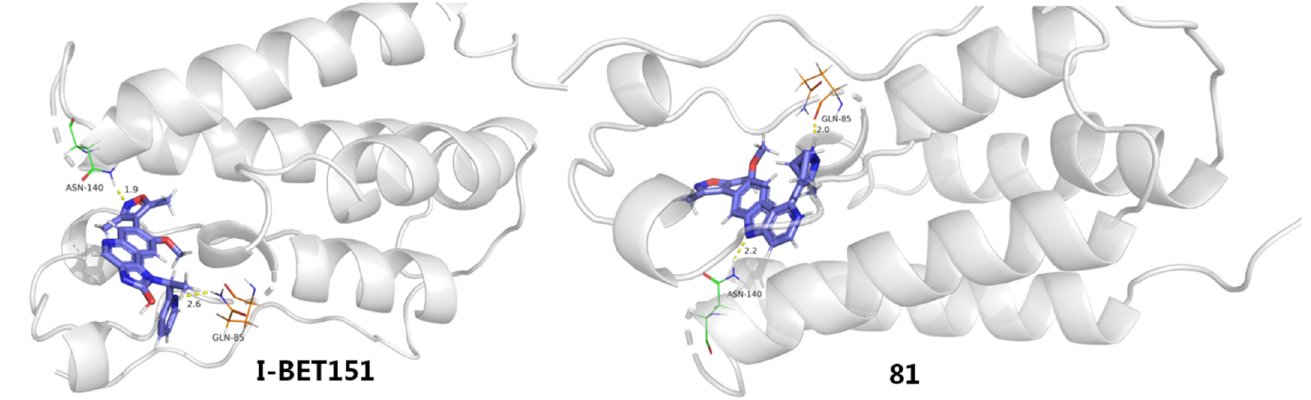
Figure 15. Binding mode comparison between I-BET151 and 81.